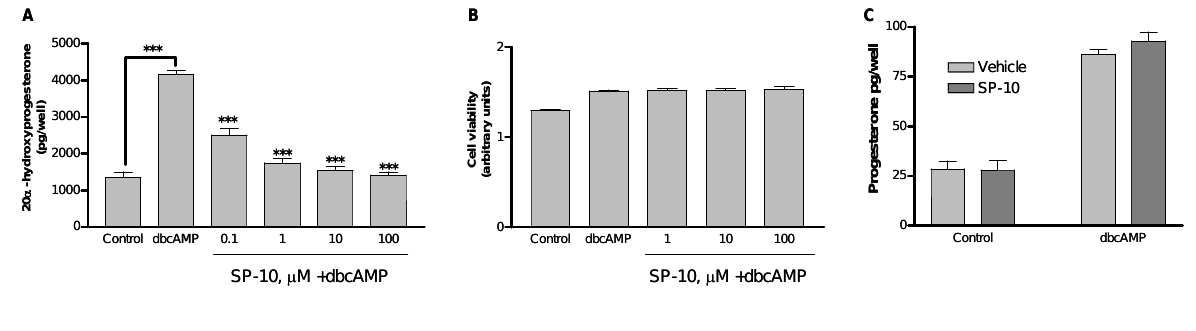
Figure 2. Effect of SP10 on the dbcAMP-induced 20  -hydroxyprogesterone synthesis and cell viability. Y-1 cells were incubated with the indicated concentrations of the SP-10 for 48 h. Culture medium was then changed and cultures were incubated with 1mM dbcAMP for an additional 48 h. (A) 20  -hydroxyprogesterone levels in the culture medium were determined by radioimmunoassay. (*** p < 0.001, ANOVA followed by Scheffe F test) (B) Alternatively, cell viability was measured using the MTT assay. (C) MA-10 Leydig cells were treated with dbcAMP ± 10  M SP-10 using the same protocol as for Y-1 cells, and progesterone levels in culture media were determined. Results are presented as mean  SD and represent three independent experiments performed in triplicate.